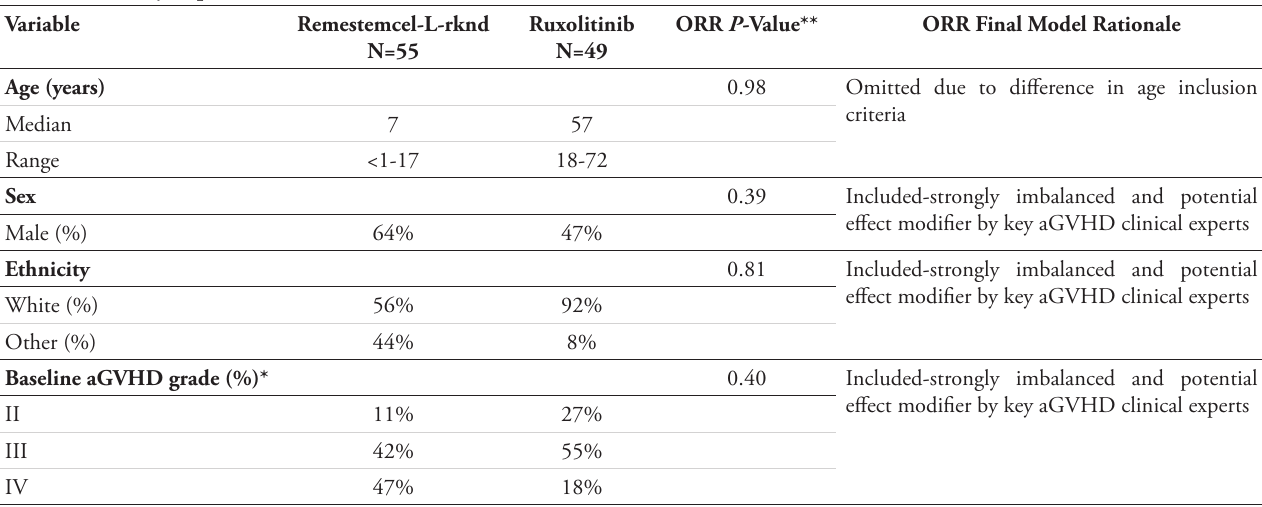
Table 1. Mutually Reported Baseline Characteristics